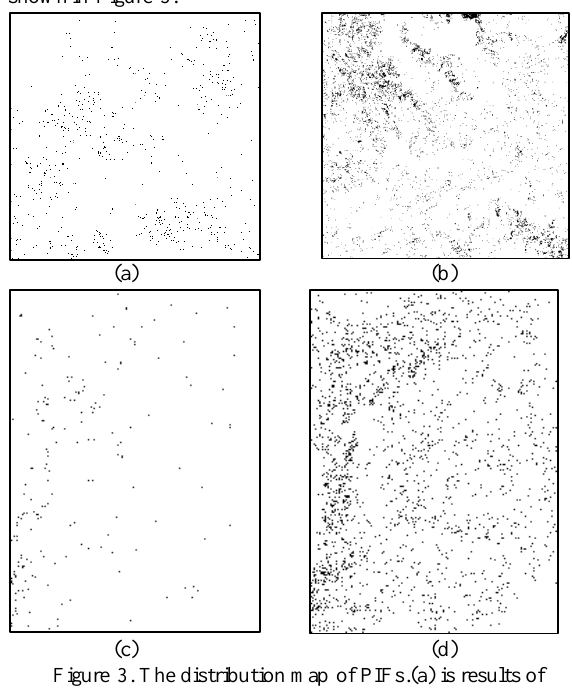
(a) is the original Landsat-8 image (b)is relative radiometric correction result of CCA; (c) is relative radiometric correction Figure 2.MAD results. (a) is 𝝎 map of Landsat-8 extracted by CCA. (b) is 𝝎 map of Landsat-8extracted by KCCA, (c) is 𝝎 map of GF-1 extracted by CCA, (b) is 𝝎 map of GF-1 extracted by KCCA